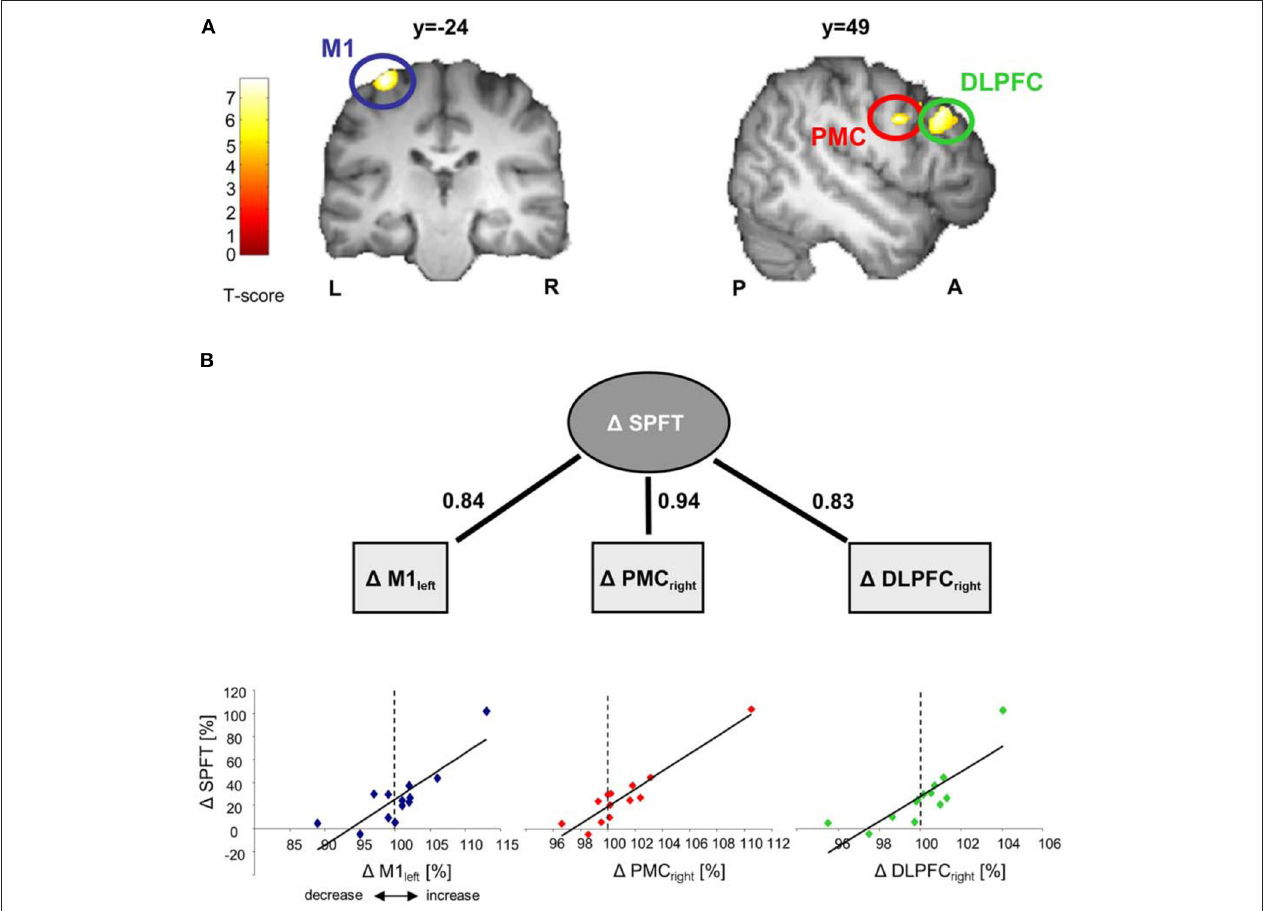
right premotor cortex (PMC) and dorsolateral prefrontal cortex (DLPFC) and sequence-specific performance improvements [%] in the SPFT. Please note that the subject with the highest change in GM and SPFT is the same across the three brain areas (left M1, right ventral PMC, and right DLPFC) (B) . Solid lines indicate significant correlations (where numbers indicate the respective r -values). (cid:2) represents % signal changes in GM or performance improvements in the SPFT. L, left ; R, right ; P, posterior ; A,